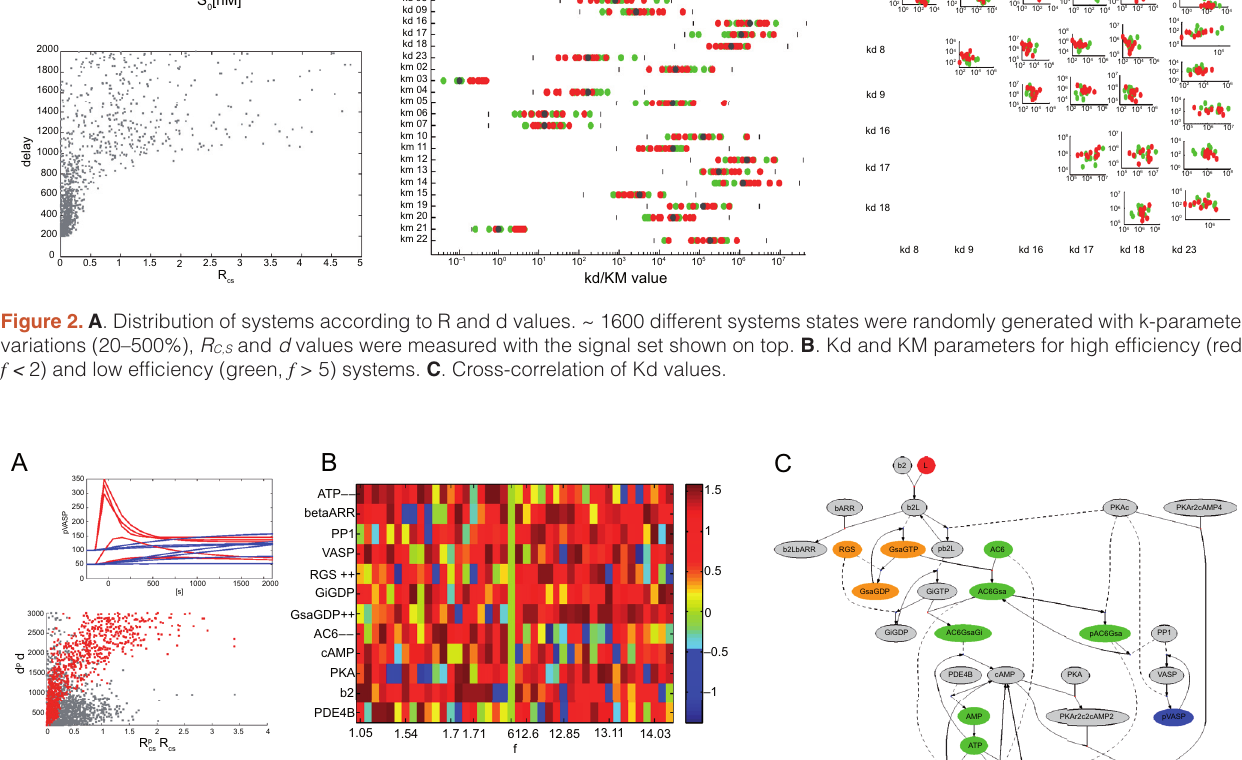
< 3, blue) or high ( f > 10, red) propensity for a transient response. transient transient (grey) or R , d (red). B . Concentration changes in response to C,S C,S . C . Concentration shifts (orange=high, transient